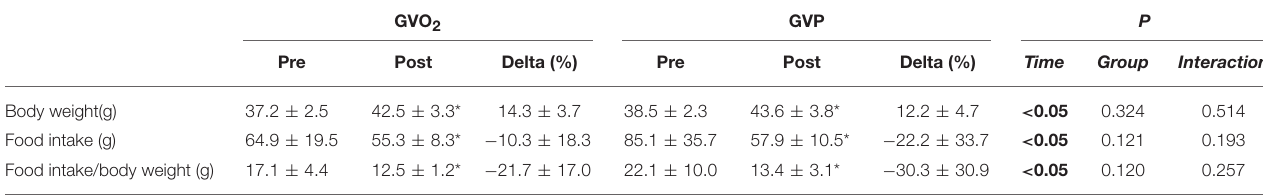
TABLE 1 | Body weight, food intake and food intake/body weight in pre- and post-training.